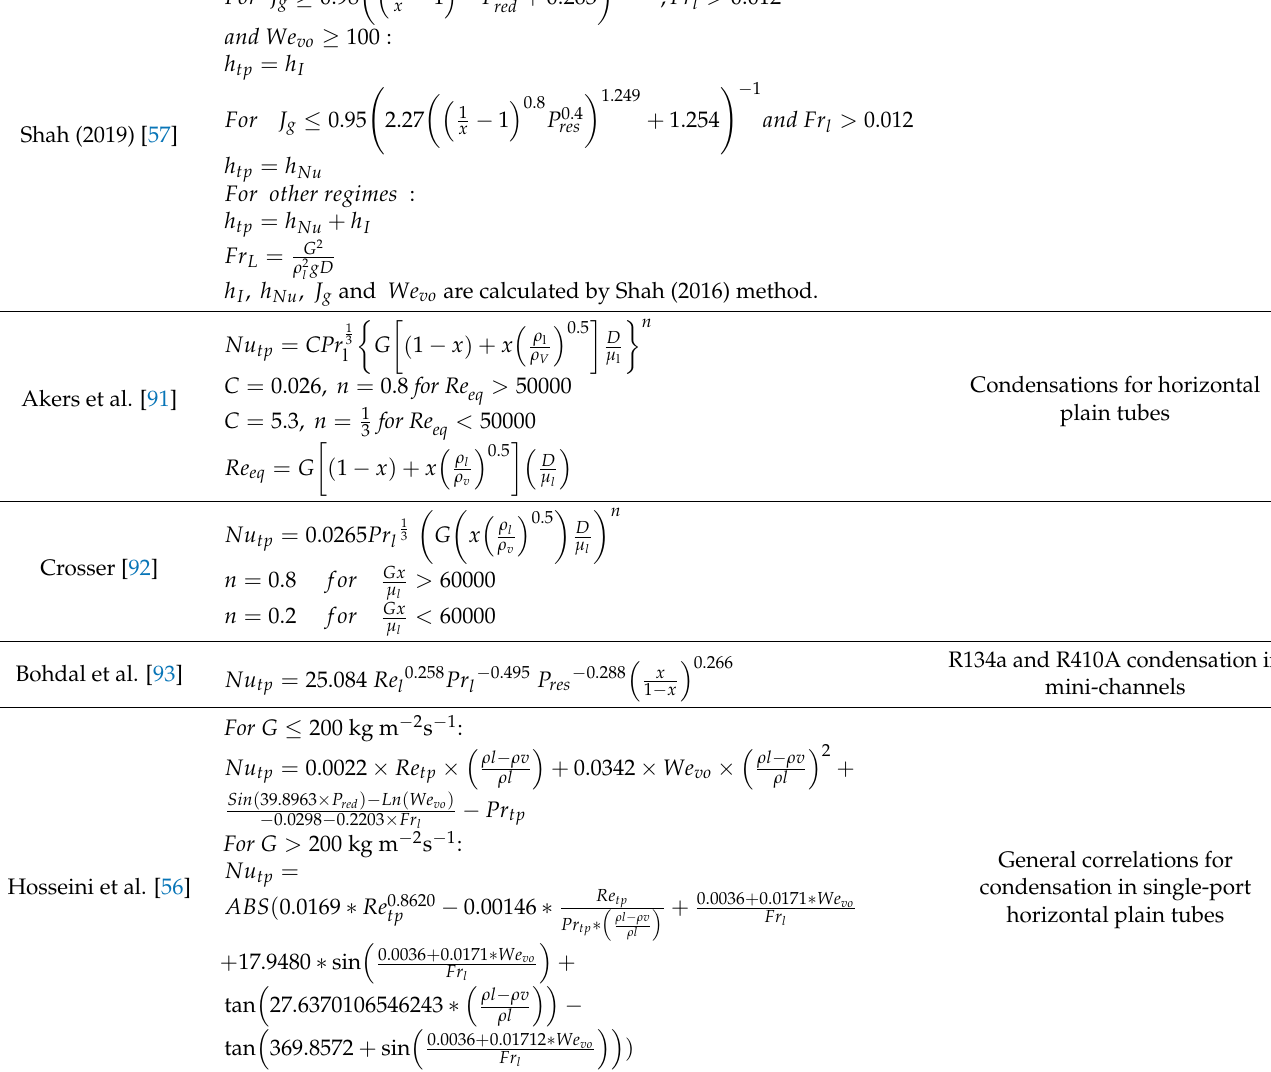
General correlations for condensation in horizontal